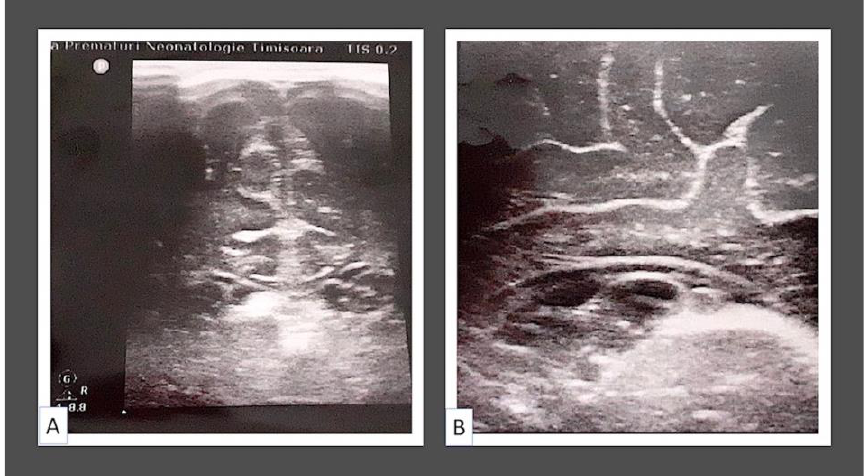
Figure 3. General overview of transcalvarial assessment ( A ) and detail of transcalvarial view of subependymal cysts ( B ). Note that there were not any other congenital brain malformations observed.